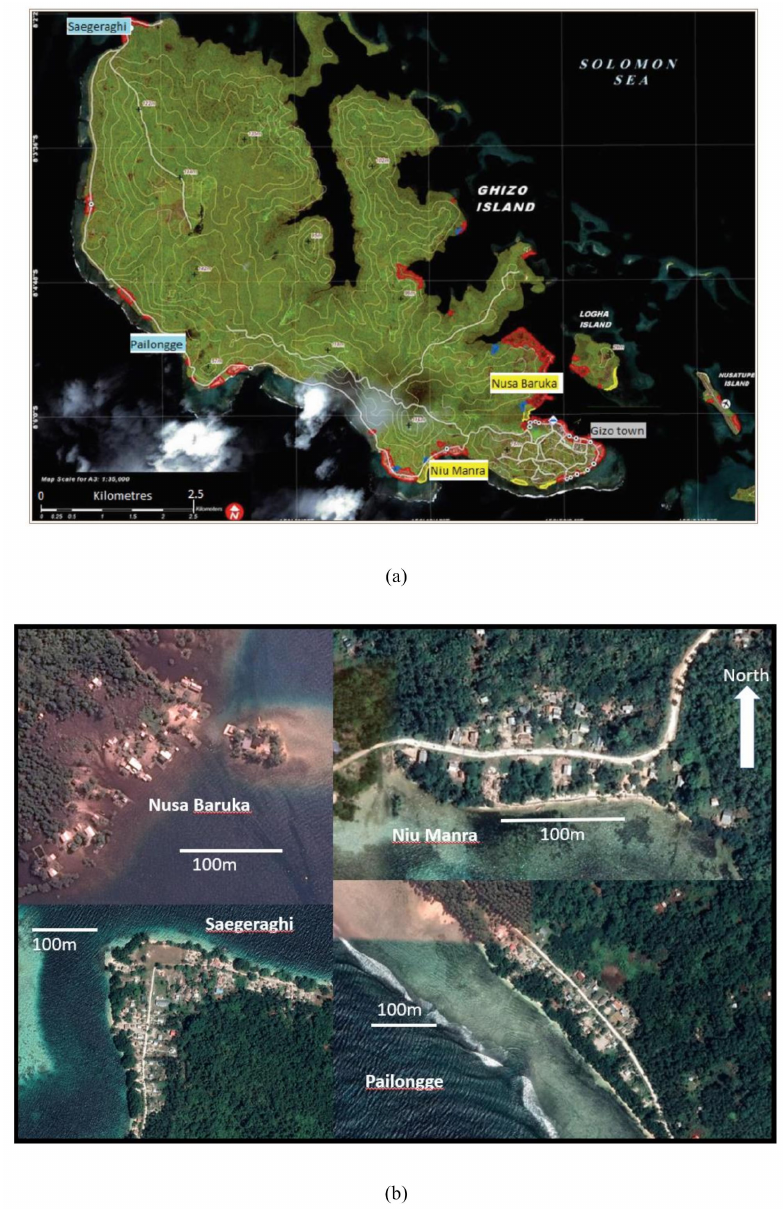
Figure 3. ( a ) Map of Ghizo indicating the location of Gizo town and the fours villages that formed the basis of this study. Saegheraghi and Pailongge are Melanesian villages, whilst Nusa Baruka and NIu Manra are Micronesian Villages. The Micronesian villages suffered more casualties from the tsunami disaster. Acknowledgements to Google Earth for the base map; ( b ) Google Earth satellite images depicting the immediate location of the villages Nusa Baruka and Niu Manra (Gilbertese Villages) and Saegeraghi and Pailongge (Melanesian villages). All villages have coastal locations. Saegheraghi is situated within a raised peninusular. Nusa Baruka occupies a predominantly mangrove- and swamp-rich area. Pailongge and Niu Manra are ribbon settlements with houses along both sides of the coastal road. Pailongge serves as an umbrella community to other nearby villages and has ready access to higher ground inland. Niu Manra is set within a flat, low-lying coastal area. The population of Ghizo Island in 2009 (Solomon Islands national Census data closest to the 2007 tsunami event) was 7177, and the populations of the villages in 2007 were approximately 114 (Saegeraghi); 76 (Pailongge); 206 (Niu Manra) and 216 (Nusa Baruka). The population of Solomon Islands in 2007 was c. 490,000 (Macadoo et al., 2008, Solomon Island Census Figures, 1999, this